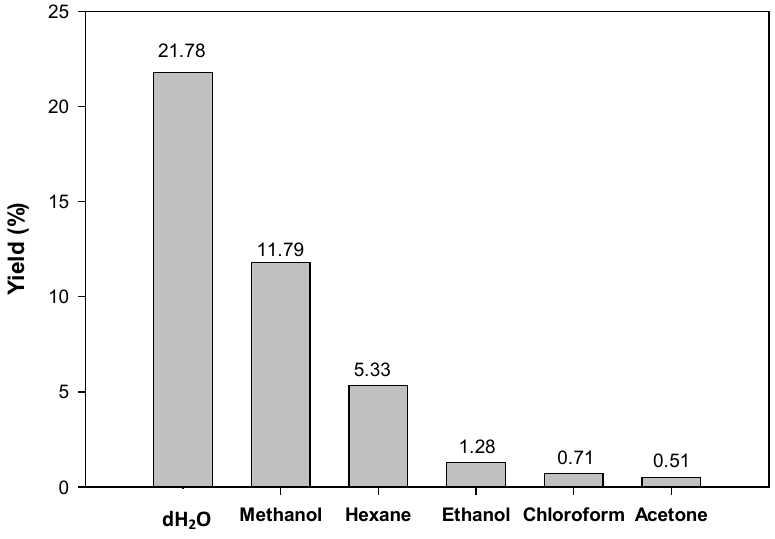
Figure 2. Yield of M. oleifera crude extracts.